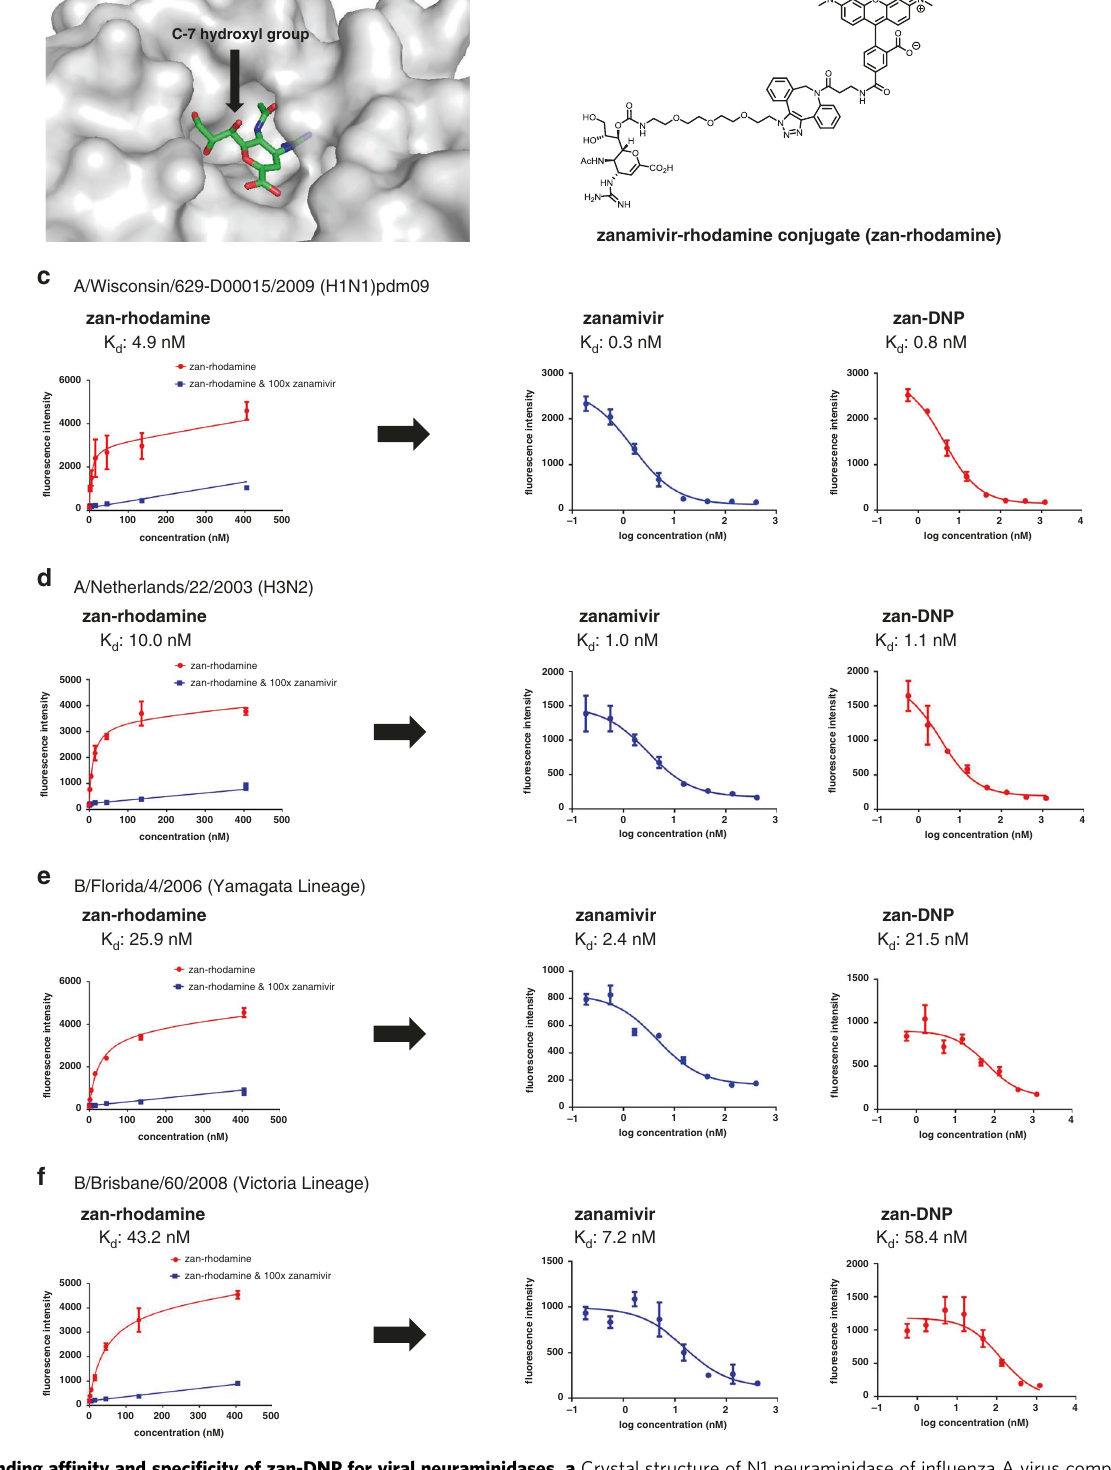
Fig. 2 Binding af fi nity and speci fi city of zan-DNP for viral neuraminidases. a Crystal structure of N1 neuraminidase of in fl uenza A virus complexed with zanamivir (PDB code: 3TI5). Note that the C-7 hydroxyl of zanamivir is exposed to solvent and available for linkage to DNP. b Structure of zanamivir- rhodamine conjugate (zan-rhodamine). c – f Binding of zan-rhodamine (direct binding curve, left panel), zanamivir (competitive binding curve, central panel), and zan-DNP (competitive binding curve, right panel) to neuraminidase expressed on MDCK cells infected with in fl uenza virus A/Wisconsin/629- D00015/2009 (H1N1)pdm09 ( c ), A/Netherlands/22/2003 (H3N2) ( d ), B/Florida/4/2006 (Yamagata Lineage) ( e ) or B/Brisbane/60/2008 (Victoria Lineage) ( f ). All the virus-infected cells were used 24 h post-infection for binding studies. Data are presented as mean values ± SD ( n =